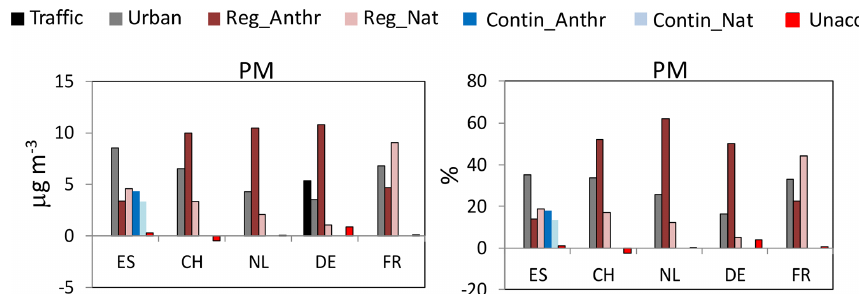
Figure 5. Lenschow’s approach applied to the concentrations of PM 10 in the different countries (PM 2 . 5 in the Netherlands). Annual means are reported. ES: Spain; CH: Switzerland; NL: the Netherlands; DE: Germany; FR: France. In all countries with the exception of Spain, Reg_Anthr and Reg_Nat are the sum of the regional and continental